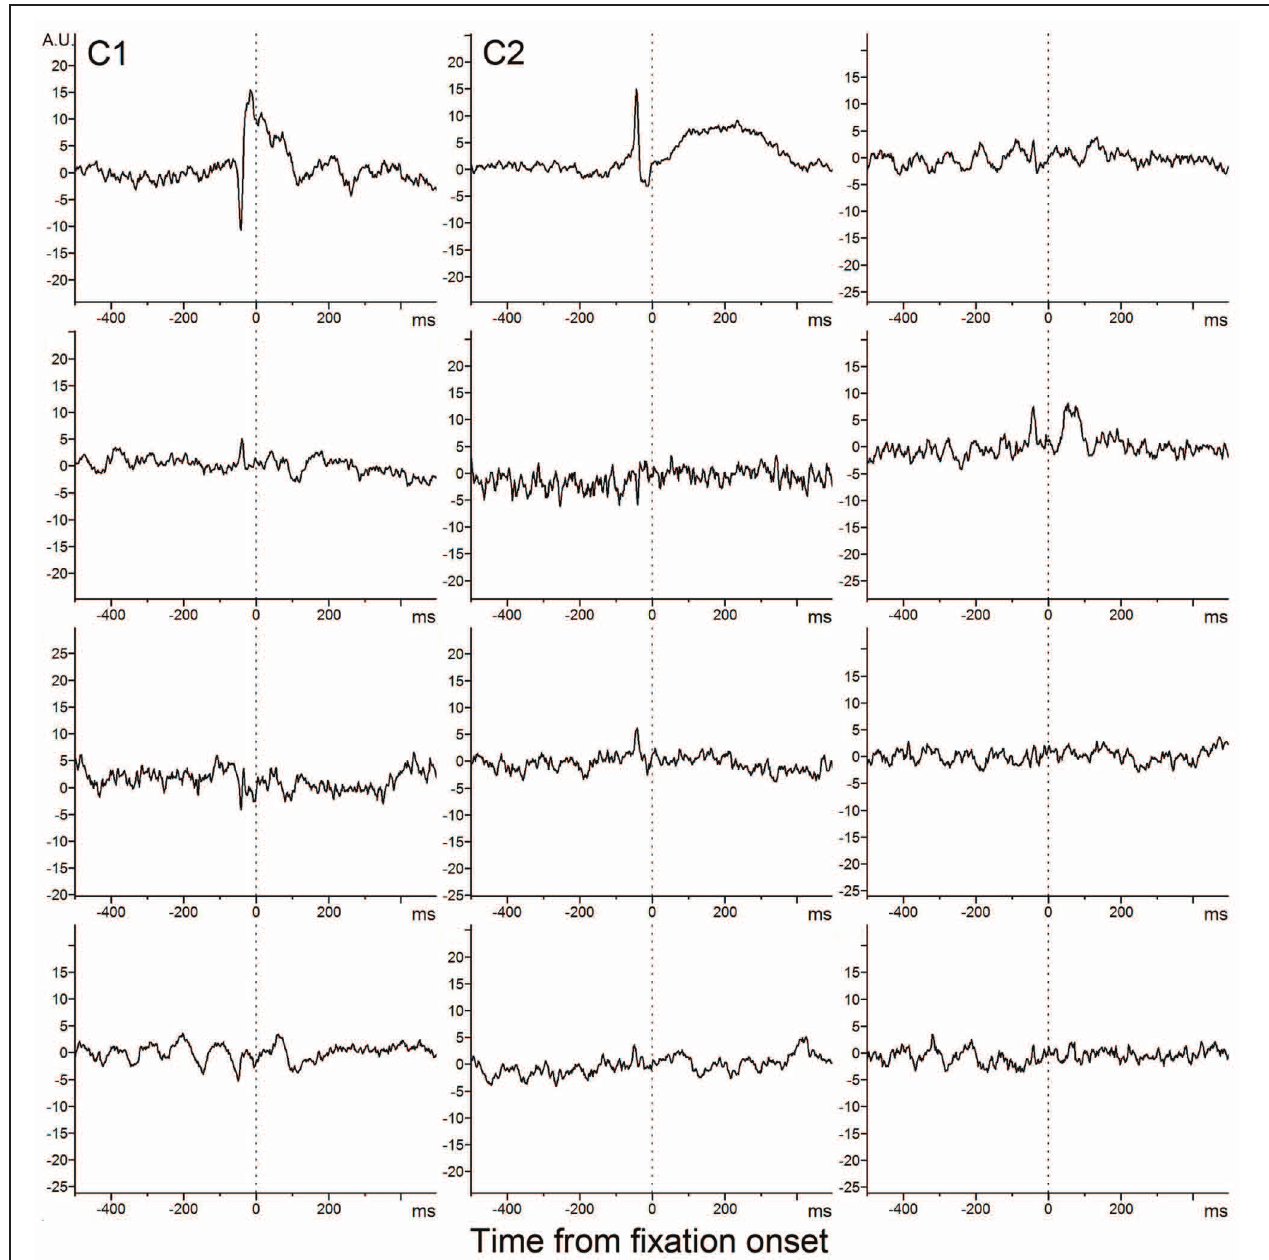
FIGURE A2 | Twelve ICA